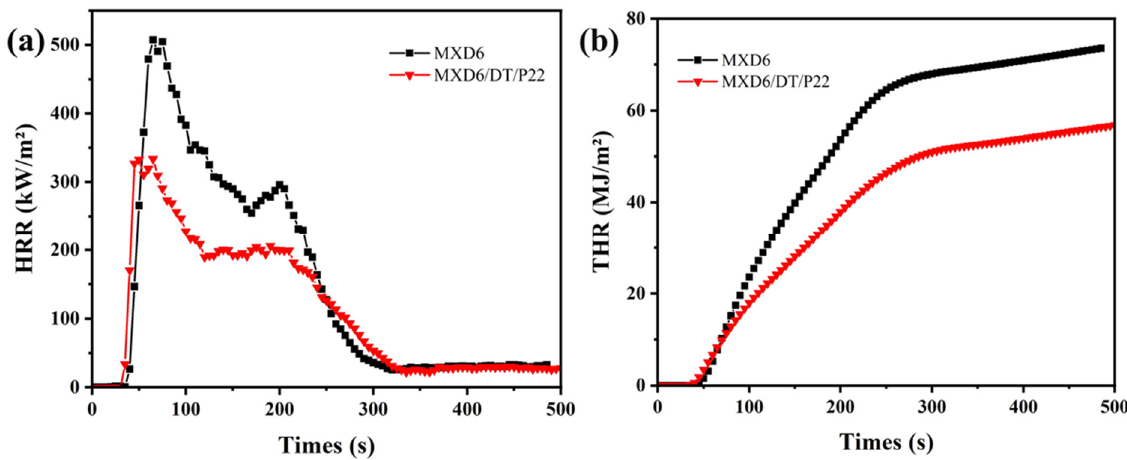
Figure 5. ( a ) HRR and ( b ) THR curves of neat MXD6 and MXD6/DT/P22 during the CCT test.